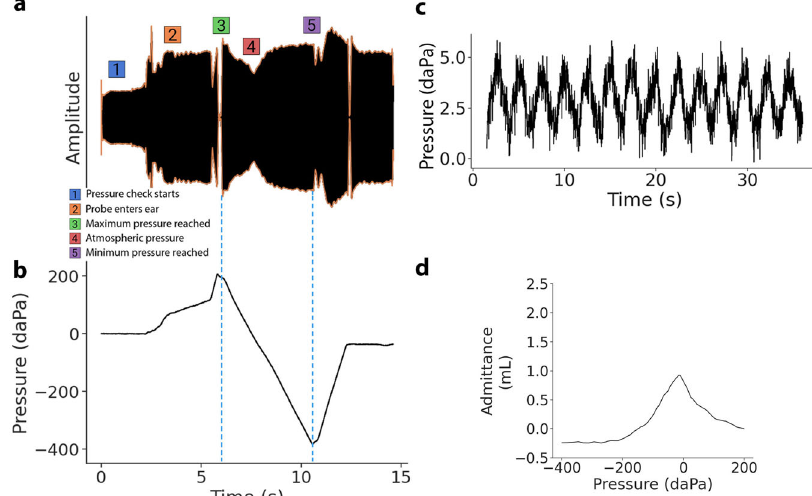
Fig. 3 Measurement procedure to obtain tympanogram. a Received acoustic signal bandpass fi ltered to 220--230 Hz. The acoustic signal increases in amplitude when it is inserted into the ear and changes in amplitude in response to air pressure changes. b Air pressure relative to atmospheric pressure as measured by the pressure sensor. The pressure signal spikes when the probe tip enters the ear. The pressure transducer performs a pressure sweep